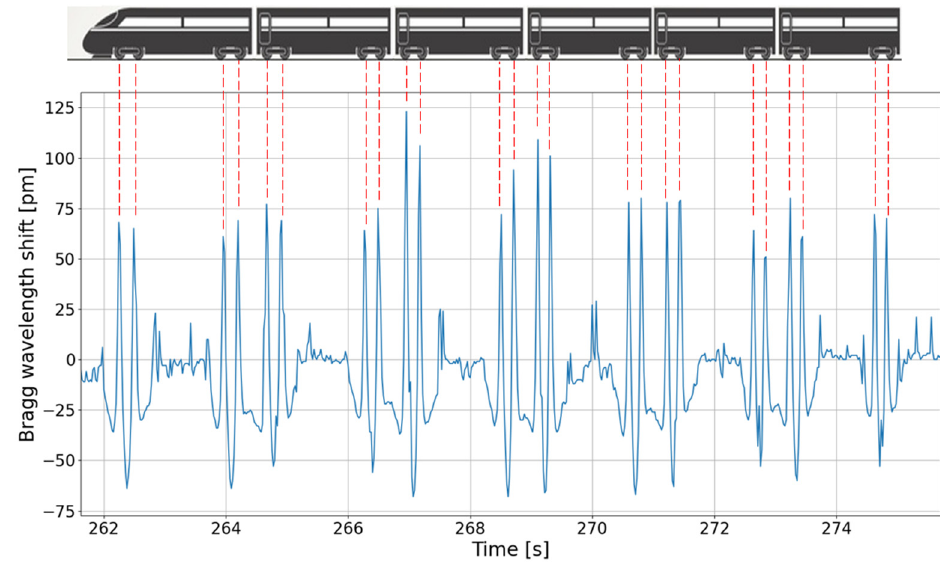
Figure 8. Evolution of the Bragg wavelength shift measured during the passage of a train.